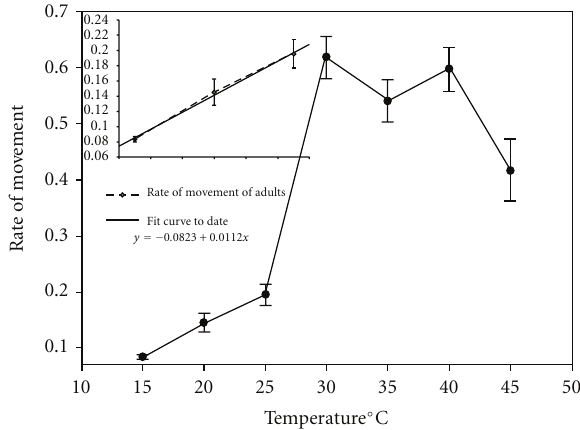
Figure 1: Rate of movement of Capnodis tenebrionis adults at di ff erent temperatures. Linear rate of movement at the first three temperatures can be observed ( R 2 = 0.996; F = 302 . 37; df = 1, 2; P = 0 . 037).